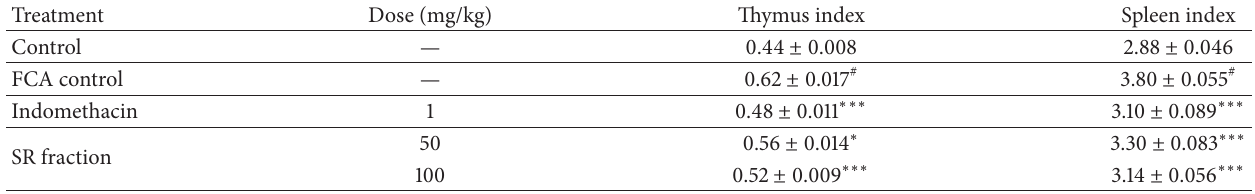
Table 2: Effect of saponin rich (SR) fraction of Achyranthes aspera on immune organs in arthritic rats. Treatment